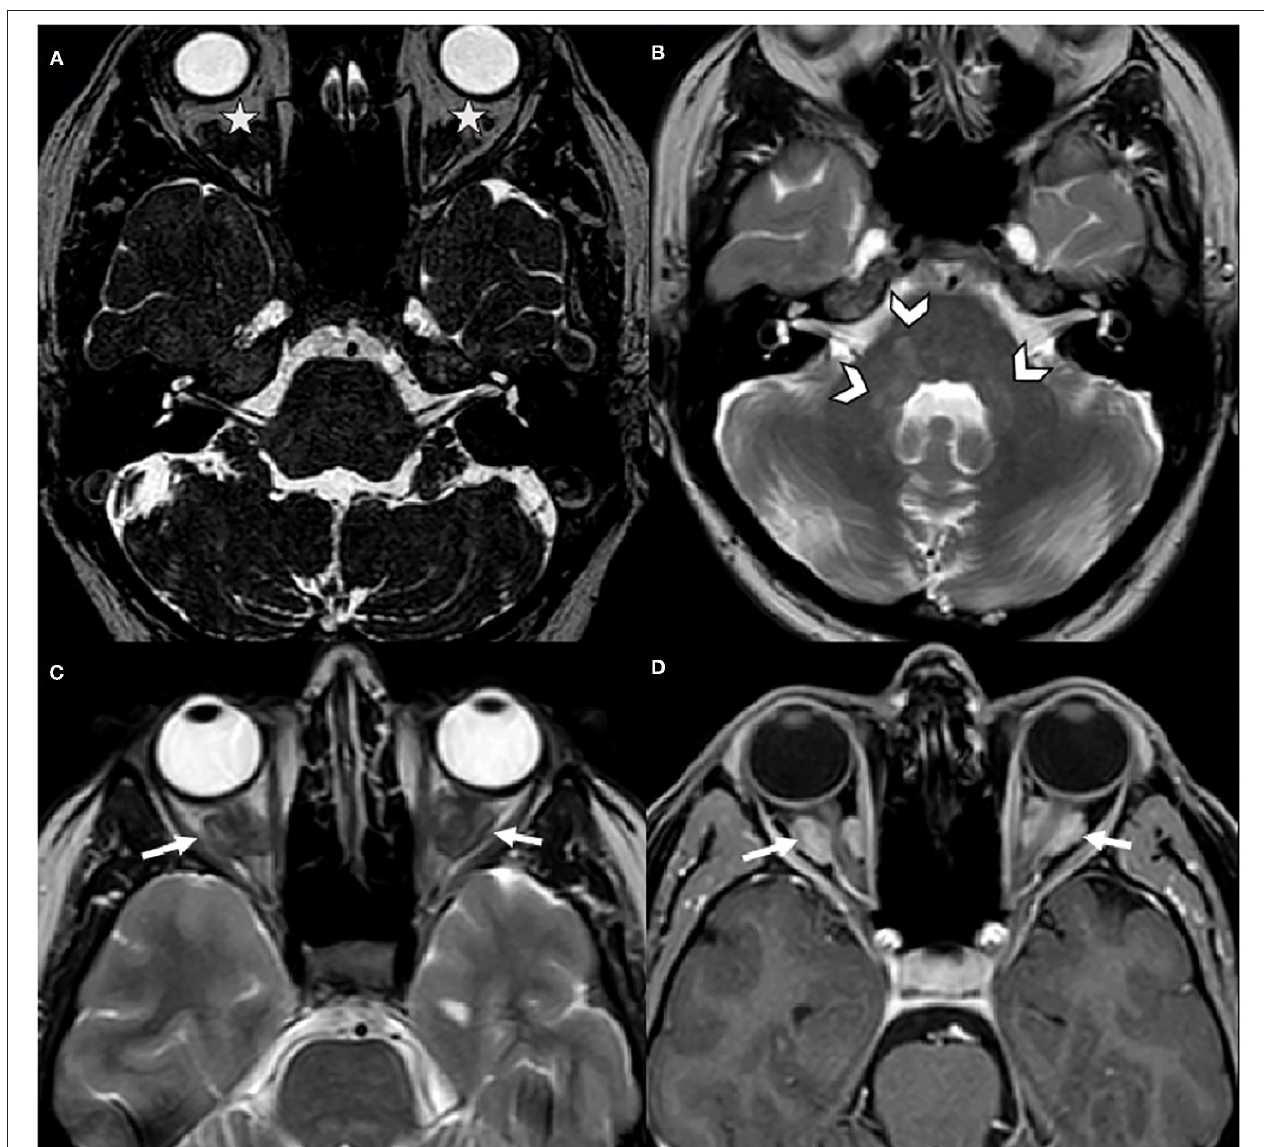
FIGURE 1 | Brain MRI. (A) Axial CISS was normal for internal auditory canals and cerebellopontine angles, but incidentally depicted bilateral intra-orbital mass lesions (stars). (B,C) Axial spin echo T2-weighted images revealed hyperintensities in the pons and the middle cerebellar peduncles (arrowheads) and demonstrated bilateral hypointense retro-ocular mass lesions (arrows). (D) Axial post-gadolinium T1-weighted image, these lesions surrounded the optic nerves sheaths and were avidly enhanced (arrows).